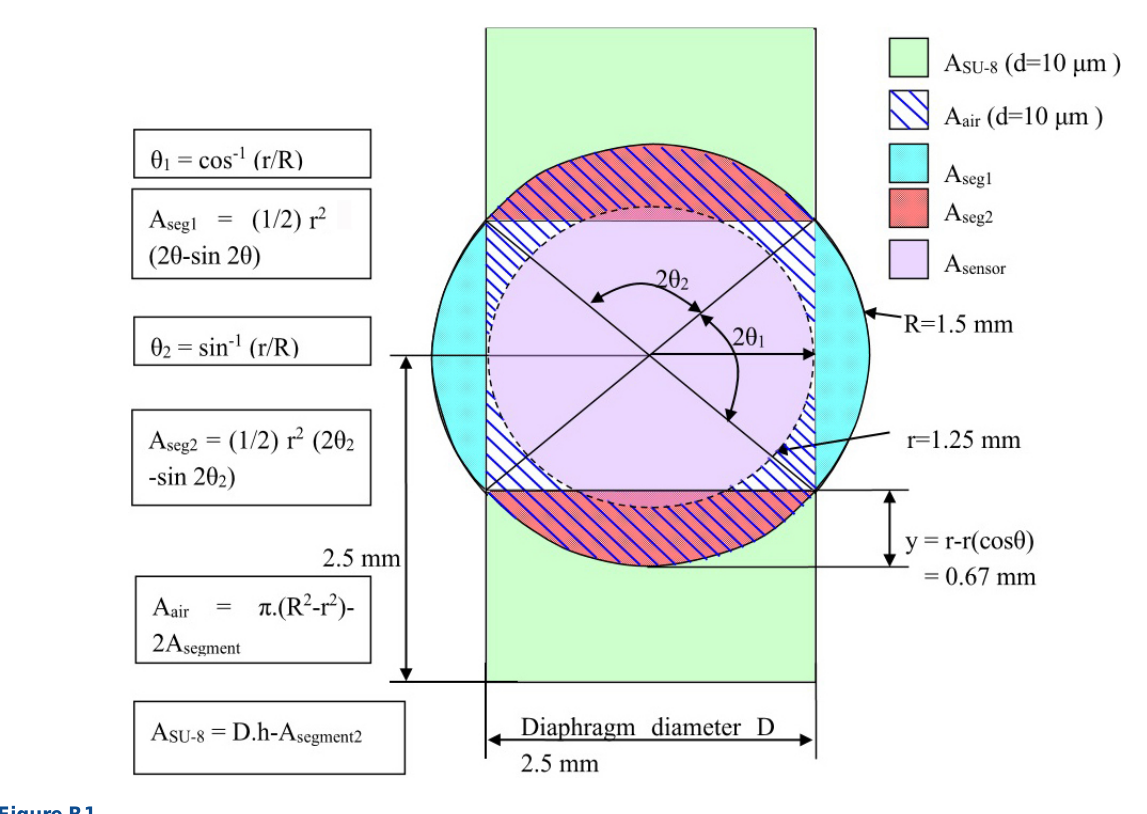
C sensor = ε air ( A air / 2µm) = 21 . 7pF C o = C sensor + C p = 41 .